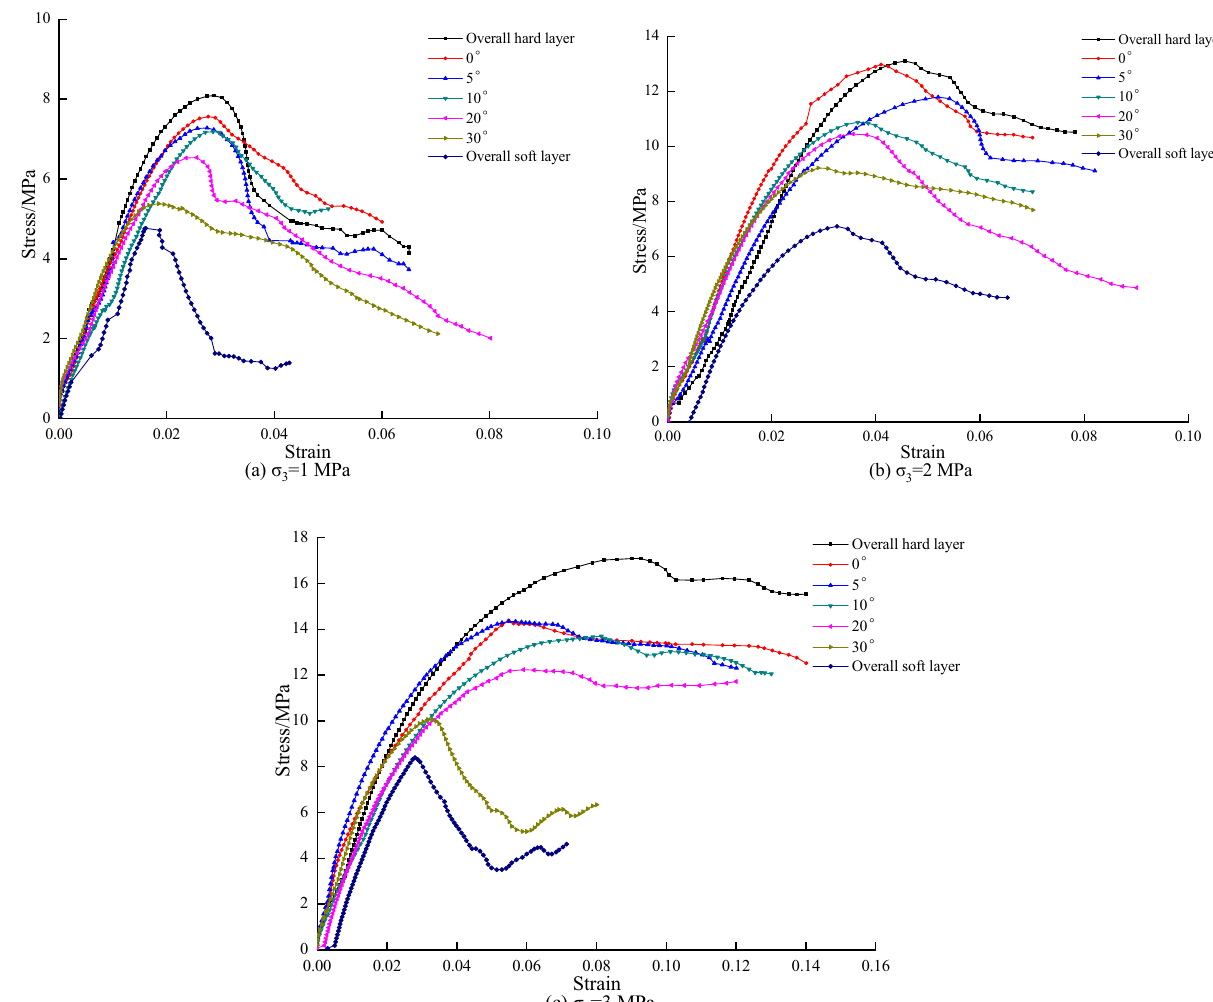
Figure 4. Stress–strain curve of coal–rock combined.